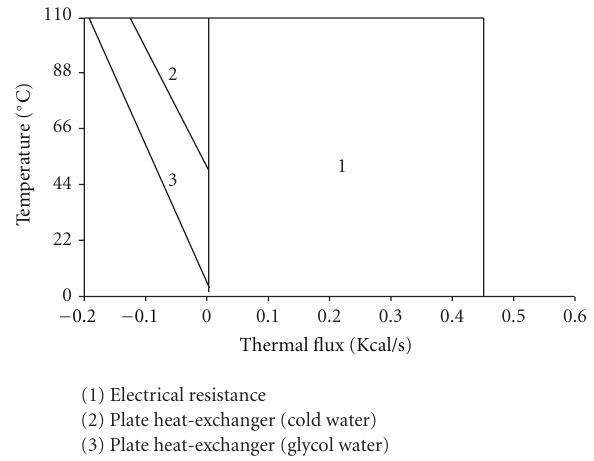
Figure 3: Evolution of the thermal flux capacities for the di ff erent